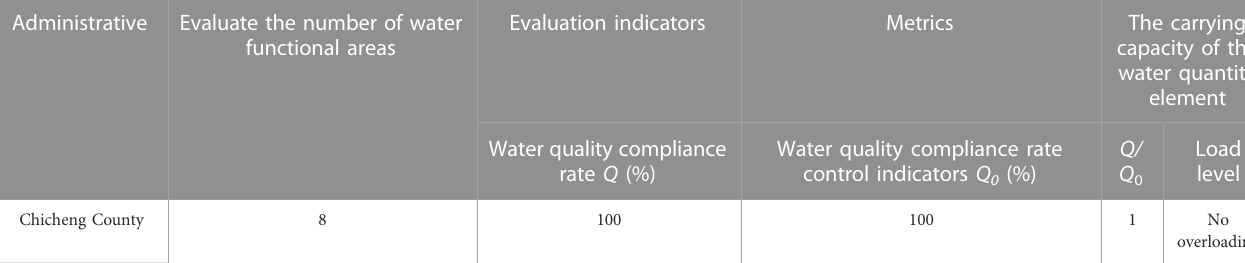
TABLE 5 Status quo year (2018) water quality compliance rate element evaluation results table.